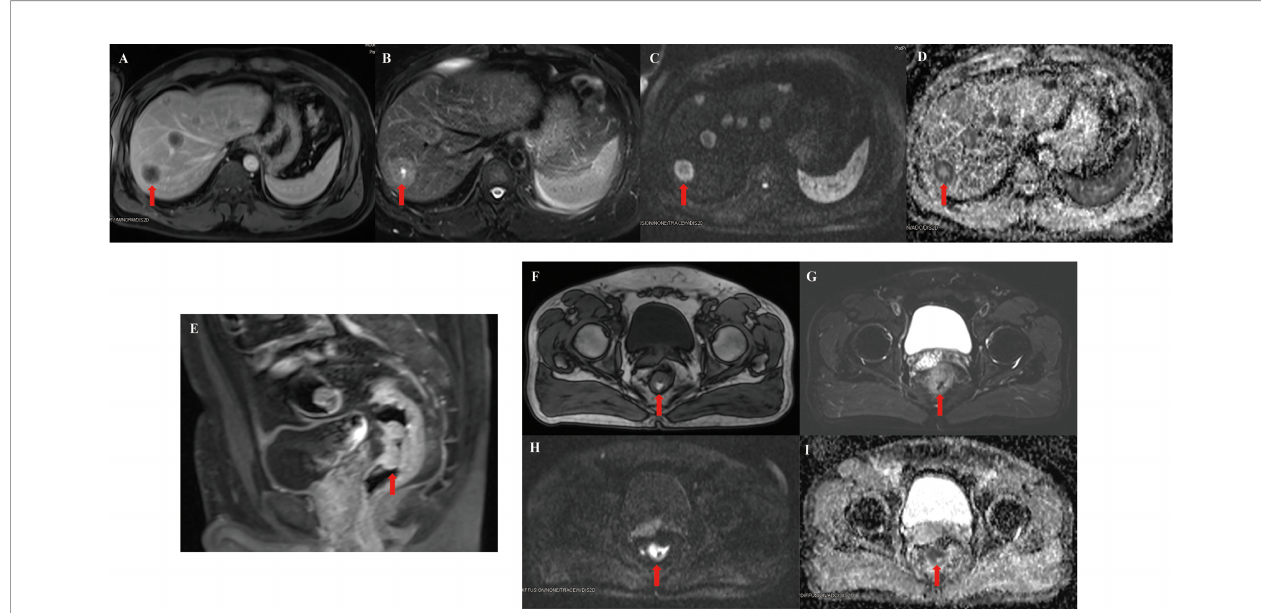
FIGURE 1 | Representative magnetic resonance imaging (MRI) images of lesions. (A – D) Representative images of T1-weighted imaging (T1WI), T2-weighted imaging (T2WI), diffusion-weighted imaging (DWI), and apparent diffusion coef fi cient (ADC) in the liver. (E – I) Representative images of rectum lesions in the sagittal position and coronal position (T1WI, T2WI, DWI and ADC), respectively. Red arrows indicate typical liver or rectum